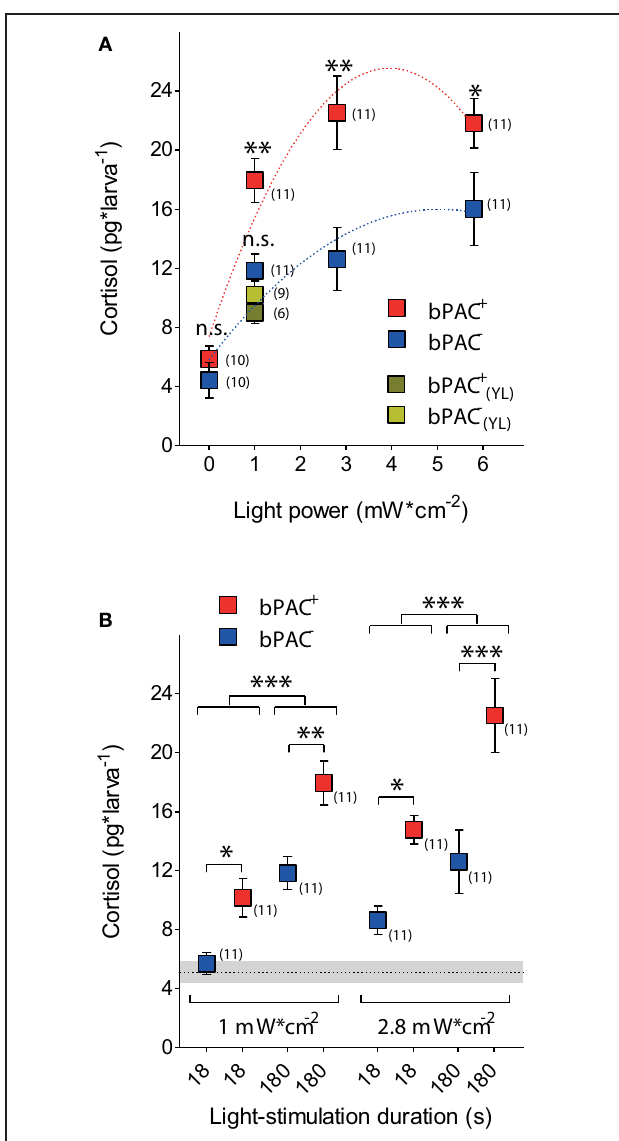
FIGURE 3 | Optogenetic elevation of stress-induced cortisol level. (A) A 180s squared pulse of blue-light leads to higher cortisol levels in bPAC-positive larvae (bPAC + ) as compared to their negative siblings (bPAC − ) (asterisks indicate statistical differences between groups at p < 0 . 05 or p < 0 . 01; sample size in parenthesis; the red and blue dashed lines depict significant non-linear regressions of cortisol vs. light-power for bPAC + and bPAC − larvae, respectively). Note that yellow-light fails to differentially enhance cortisol level in bPAC + larvae. (B) Cortisol level in bPAC + and bPAC − larvae as a function of exposure time and light-power (asterisks indicate statistical differences between groups at p < 0 . 05, p < 0 . 01, or p < 0 . 001; sample size in parenthesis; Mean ± S . E . M . basal levels shown as dotted line and gray background,